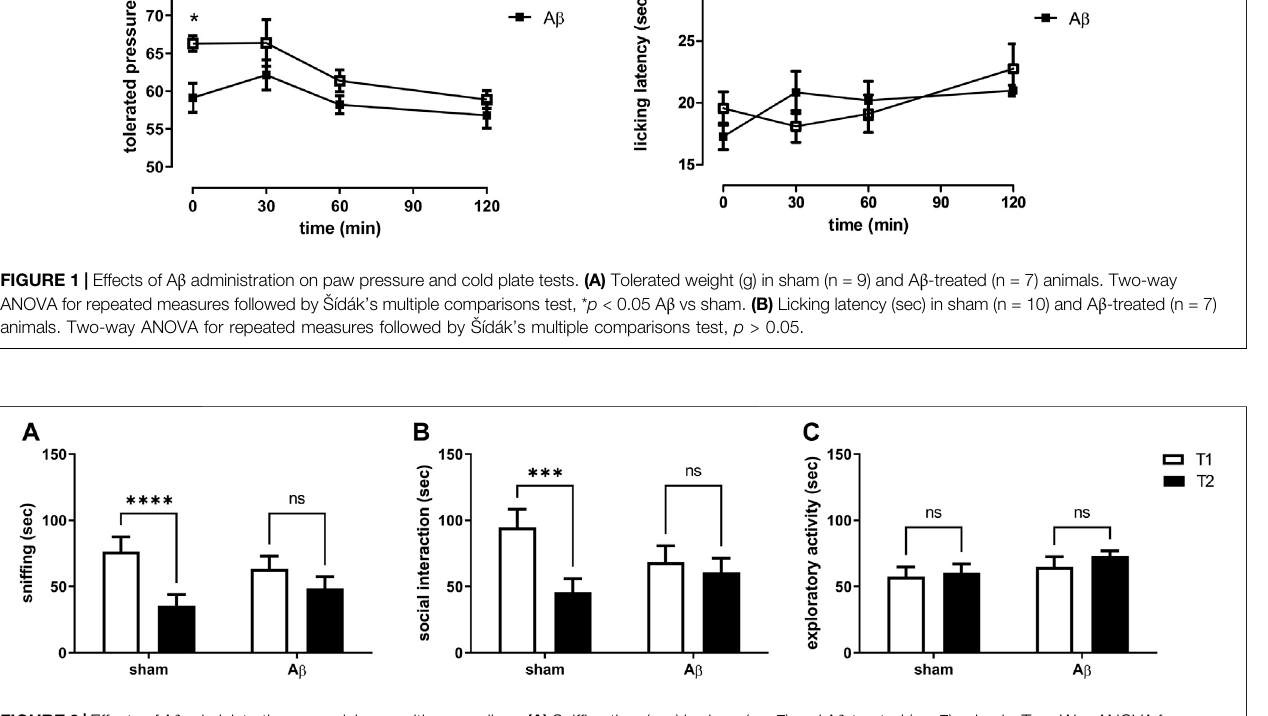
FIGURE 2 | Effects of A β administration on social recognition paradigm. (A) Snif fi ng time(sec) in sham (n (cid:1) 7) and A β -treated (n (cid:1) 7) animals. Two-Way ANOVA for repeated measures followed by Š ídák ’ s multiple comparisons test, **** p < 0.0001 A β vs sham. (B) Social interaction time (sec) in sham (n (cid:1) 7) and A β -treated (n (cid:1) 7) animals.Two-wayANOVAforrepeatedmeasuresfollowedby Š ídák ’ smultiplecomparisonstest,*** p < 0.001A β vssham. (C) Exploratoryactivitytime(sec)insham(n (cid:1) 7) and A β -treated (n (cid:1) 7) animals. Two-way ANOVA for repeated measures followed by Š ídák ’ s multiple comparisons test, p >